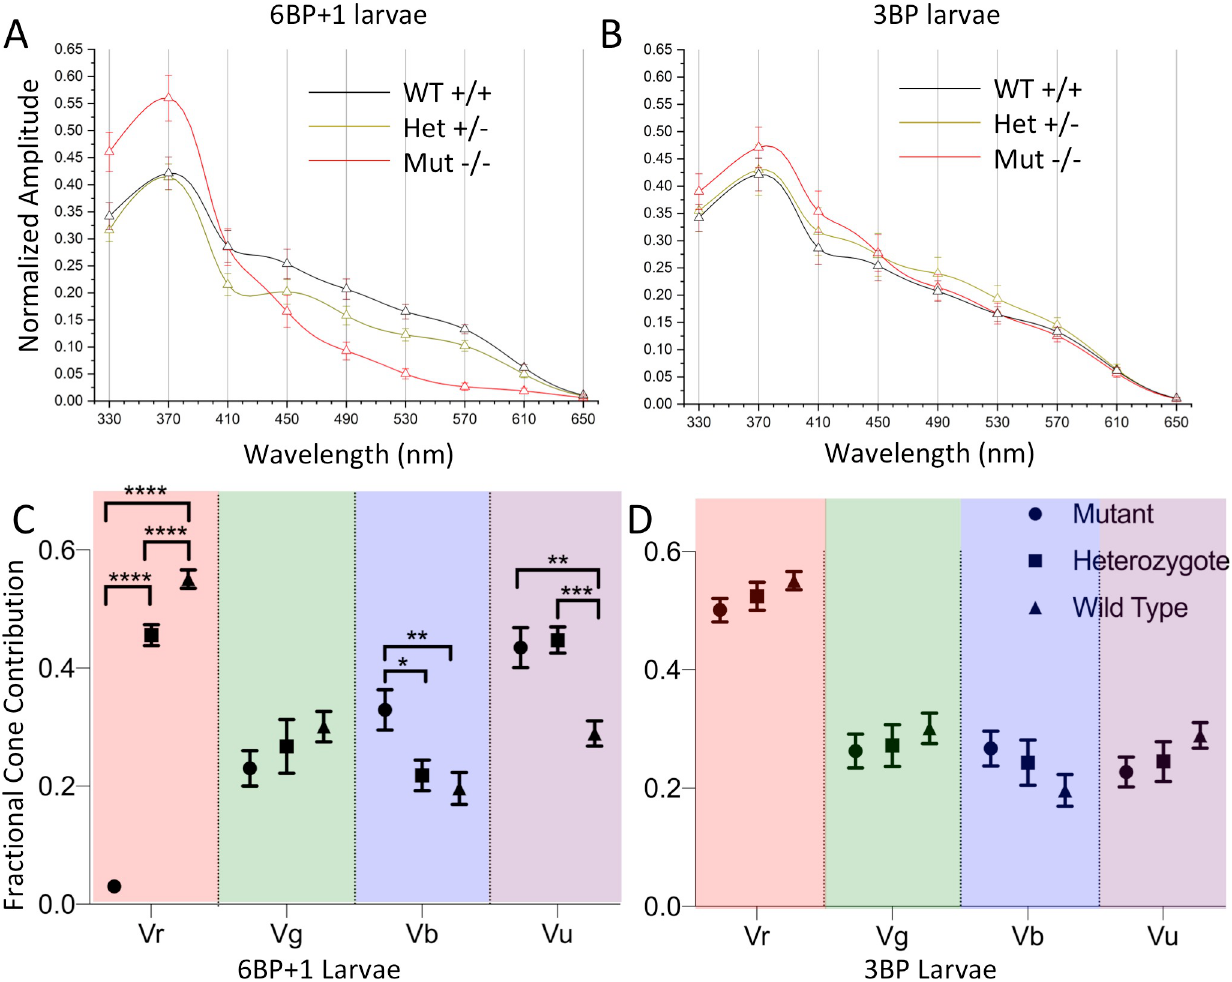
Fig 10. Spectral plots and cone contribution comparisons for 6BP+1 and 3BP larva. (A) Scanning from 330 nm to 650 nm with constant quantal irradiance (4.6 log(quanta � μ m − 2 � s − 1 ) the 6BP+1 mutant (N = 12) shows a large drop in response amplitude for long wavelengths and a strong preference for UV wavelengths compared to the wild type (N = 17) and heterozygote (N = 16). (B) The 3BP spectral plot shows a similar spectral pattern in response amplitude across the wavelengths between all genotypes. (C) The 6BP+1 mutant displays a significant drop in red cone contribution (Vr) accompanied by an increase in UV cone contribution (Vu). (D) The cone contribution comparisons between the 3BP genotypes show a trend towards decreasing Vr for the mutant and heterozygote as compared to wild type, though not significant. Spectral curves and fractional cone amplitudes in A-D are generated from the same datasets and model as in Fig